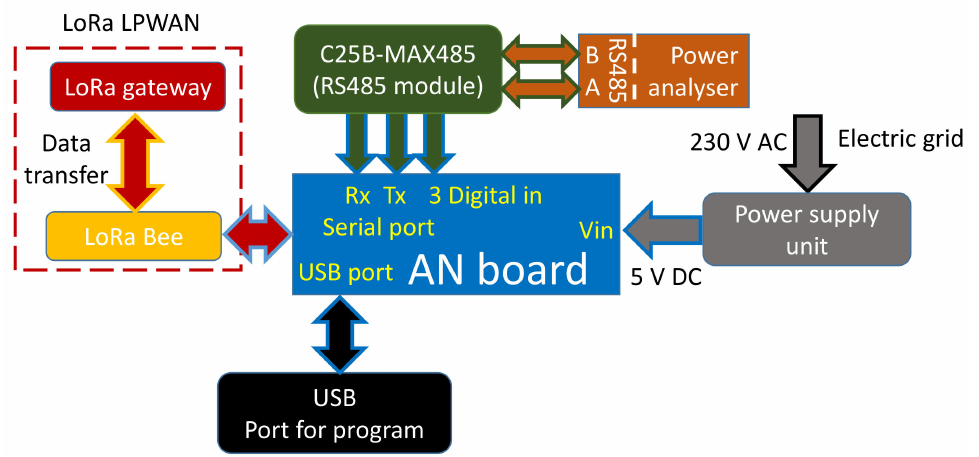
Figure 2. Hardware block diagram of the power analyzer monitor and programming device